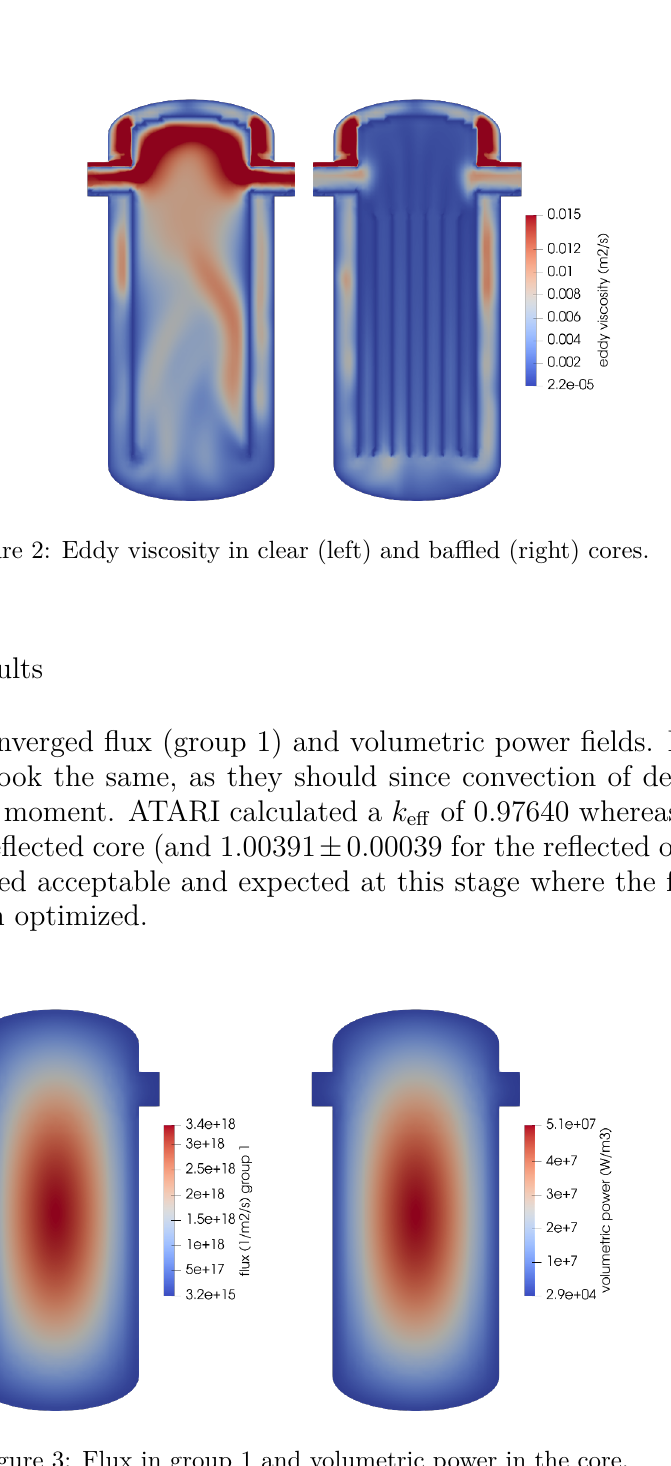
Figure 3: Flux in group 1 and volumetric power in the